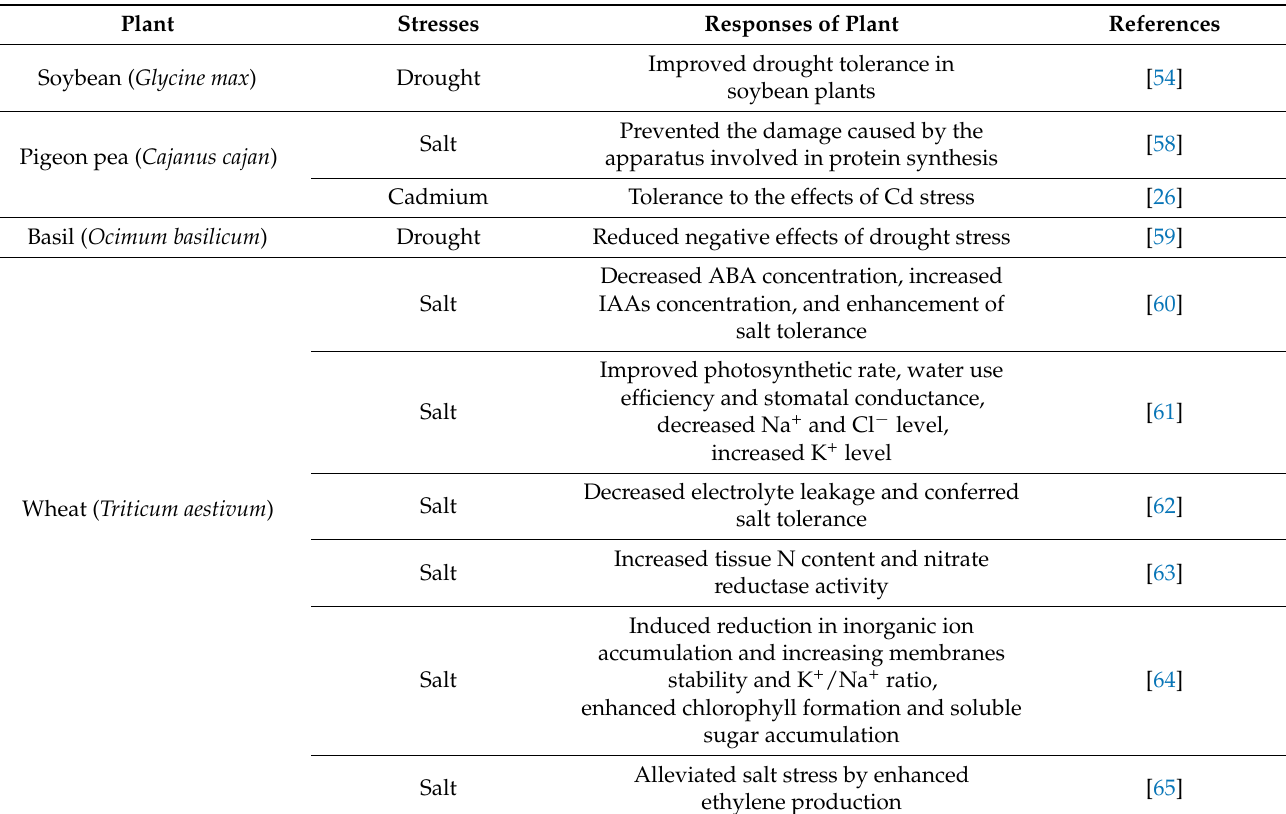
Table 1. Seed-priming with cytokinin adopted for developing abiotic stress tolerance in plants.